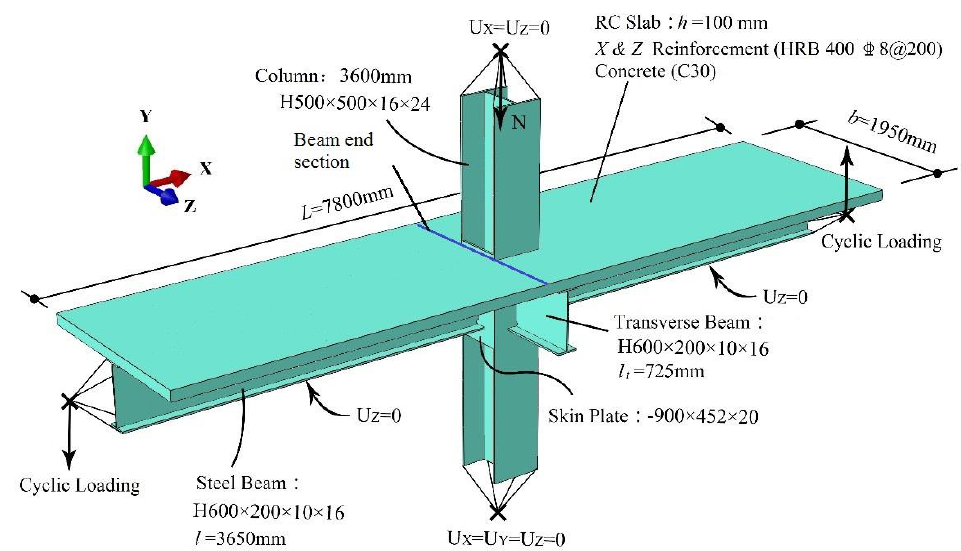
Figure 9. Details of the base composite joint in the ABAQUS analysis.